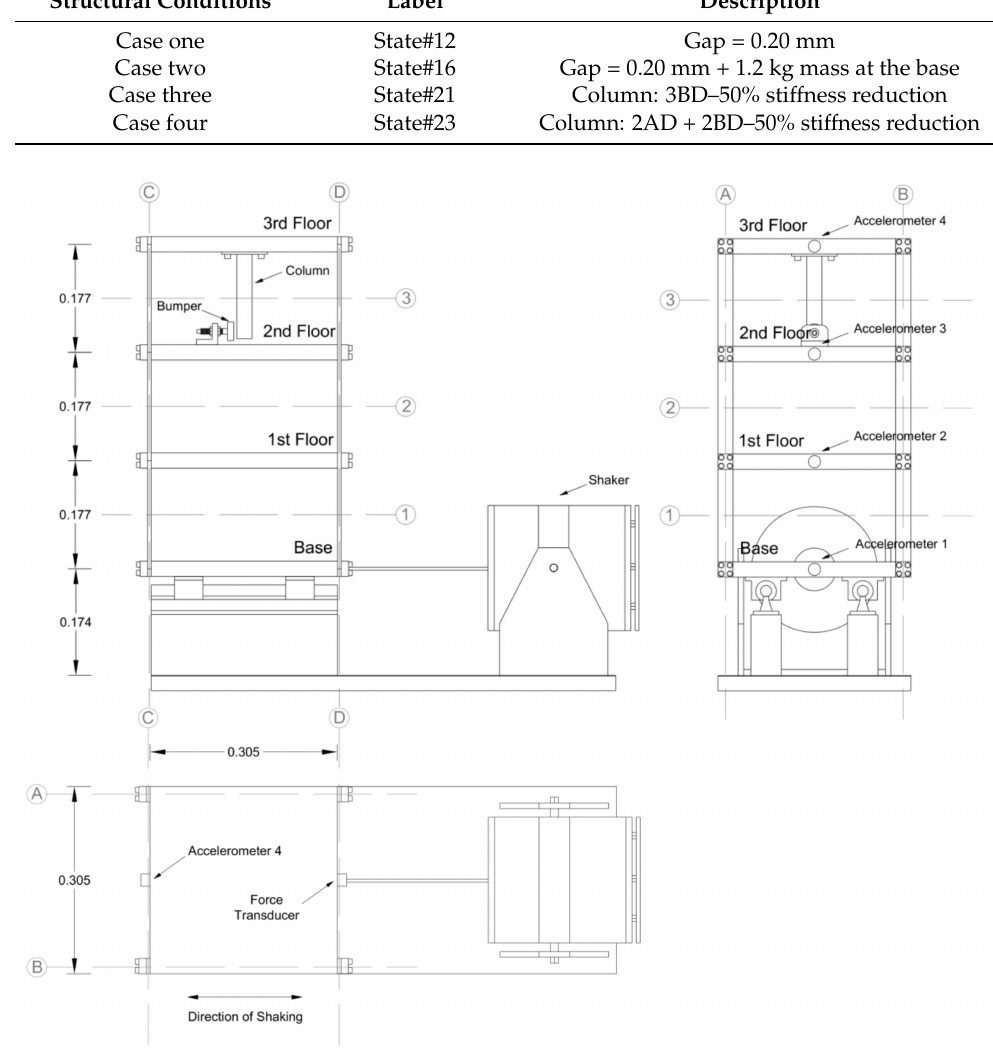
Table 4. Different structural conditions of the three-story building structure. Structural Conditions